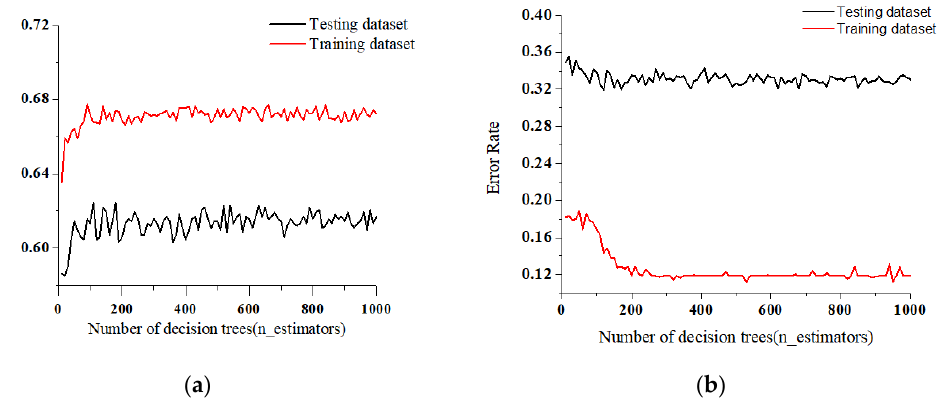
Figure 4. The relationship between model parameter "n_estimators" and model performance. ( a ) Cross-validation results and number of sub-models. ( b ) Model error rate and number of sub-mod-